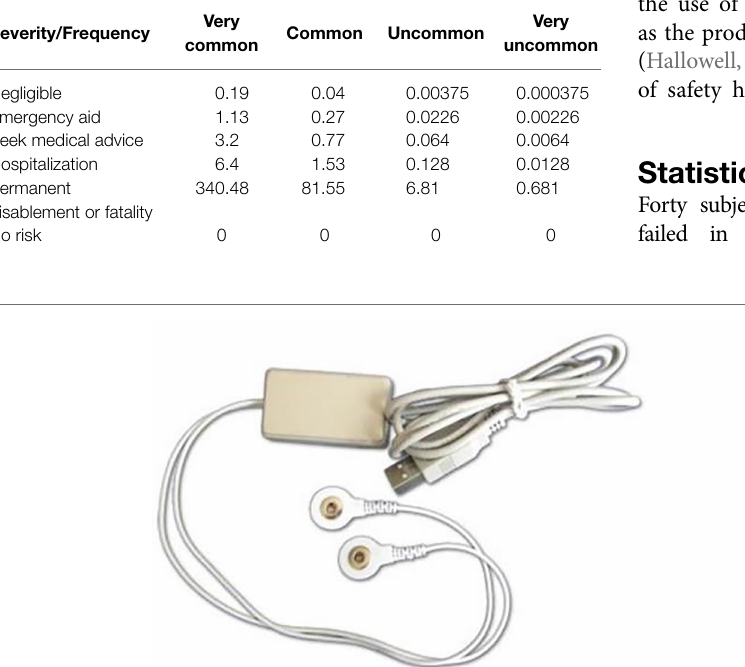
TABLE 3 | Expected frequency and severity of safety hazard.